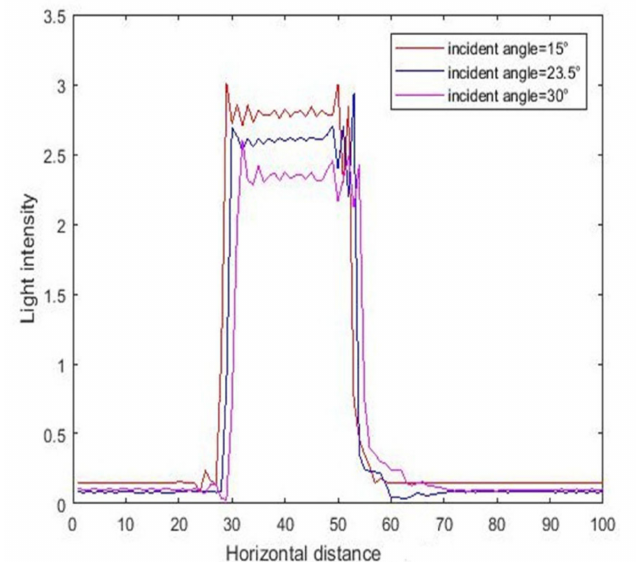
Figure 13. The intensity curve for inclined exposure with di ff erent incident angles in the X–Z cross section.